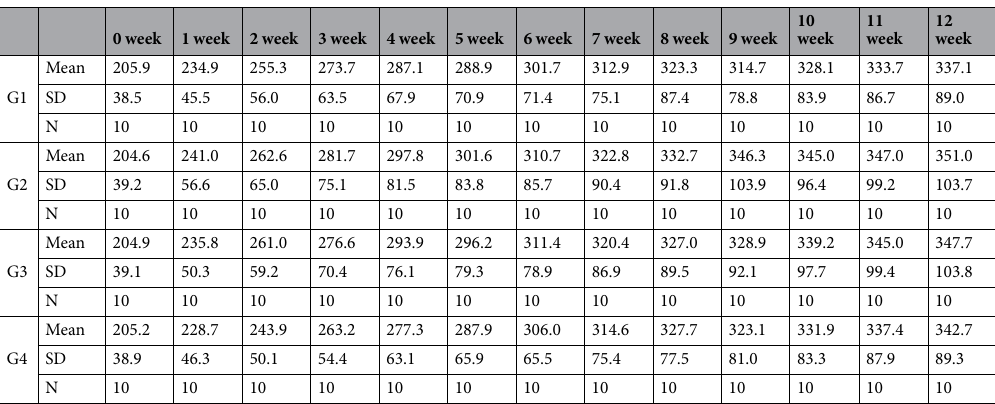
Table 2. Body weight (gram) changes of rats after SiNPs application up to 12 weeks. G: group, SD: standard deviation, N: